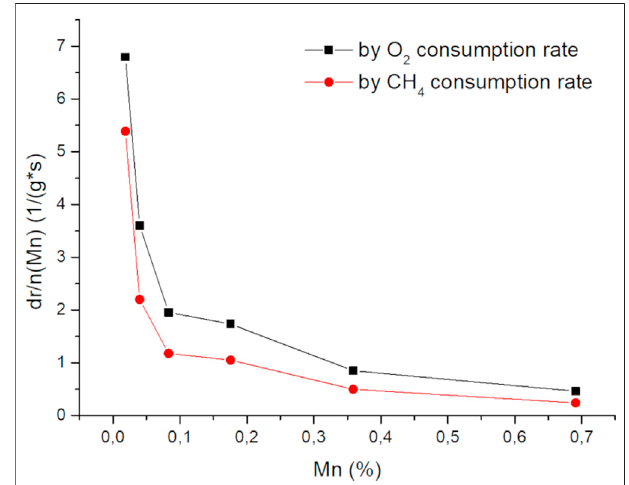
FIGURE 11 | Calculated apparent activation energy of methane and oxygen consumption vs metal content of the Mn (CO, CO 2 , C 2 H 4 , C 2 H 6 ) doped CaO catalysts (50 mg carbonate precursor, 750 mg SiC, 50 ml/min 3: 3:1 CH 4 :N 2 :O 2 , the temperature range between 650 and 800 ° C), lines are guides the eye.